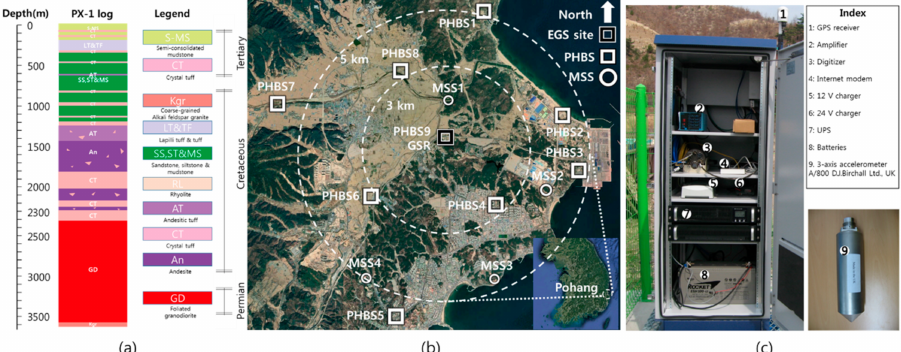
Figure 1. ( a ) PX-1 log of the Pohang enhanced geothermal system (EGS) site (modified after [34]); ( b ) the geometry of microseismic monitoring network for the EGS project. White squares and circles are shallow borehole stations named PHBSs (Pohang borehole stations) and temporal surface seismometers named MSS (mobile surface station), respectively. Deep borehole sensors such as Avalon Geochain TM Slim Receivers, which were originally used for vertical seismic profiling, were operated in the EGS site to improve the accuracy of the microseismic analysis in the stimulation periods; ( c ) the actual photographs of PHBSs and 3-axis borehole